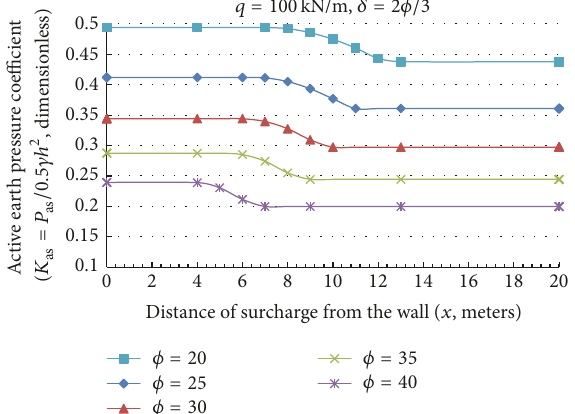
) against as Figure 6: Changes in active pressure coefficient ( 𝐾 changes in the distance of surcharge from wall for different amounts of internal soil